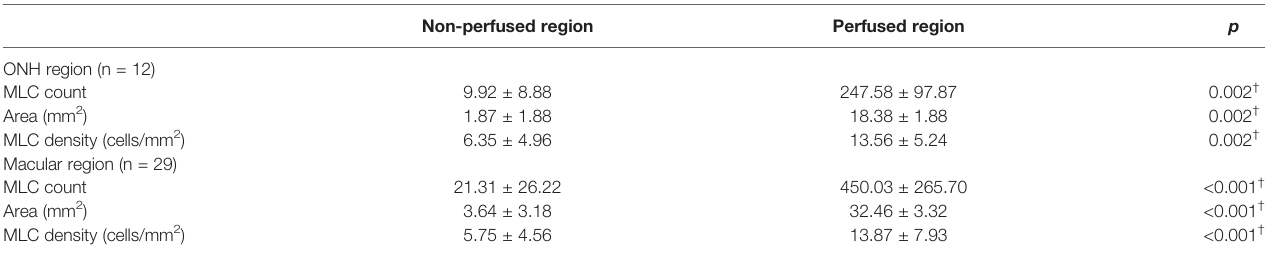
TABLE 2 | MLC parameters in non-perfused and perfused regions of the RVO eyes. Non-perfused region Perfused region p